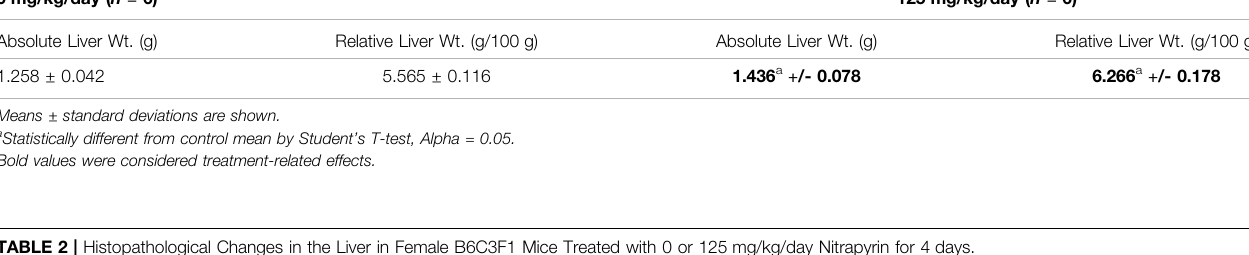
TABLE 2 | Histopathological Changes in the Liver in Female B6C3F1 Mice Treated with 0 or 125 mg/kg/day Nitrapyrin for 4 days. Dose (mg/kg/day) 0 Number examinedact Aggregates of mononuclear cells, very slight Aggregates of mononuclear cells; adjacent to necrotic or degenerative hepatocytes, very slight Hypertrophy; increased eosinophilia; hepatocyte; centrilobular/midzonal, very slight 0 Necrosis; with accompanying in fl ammation; hepatocyte; focal, moderate 0 1 Bold values were considered treatment-related effects.